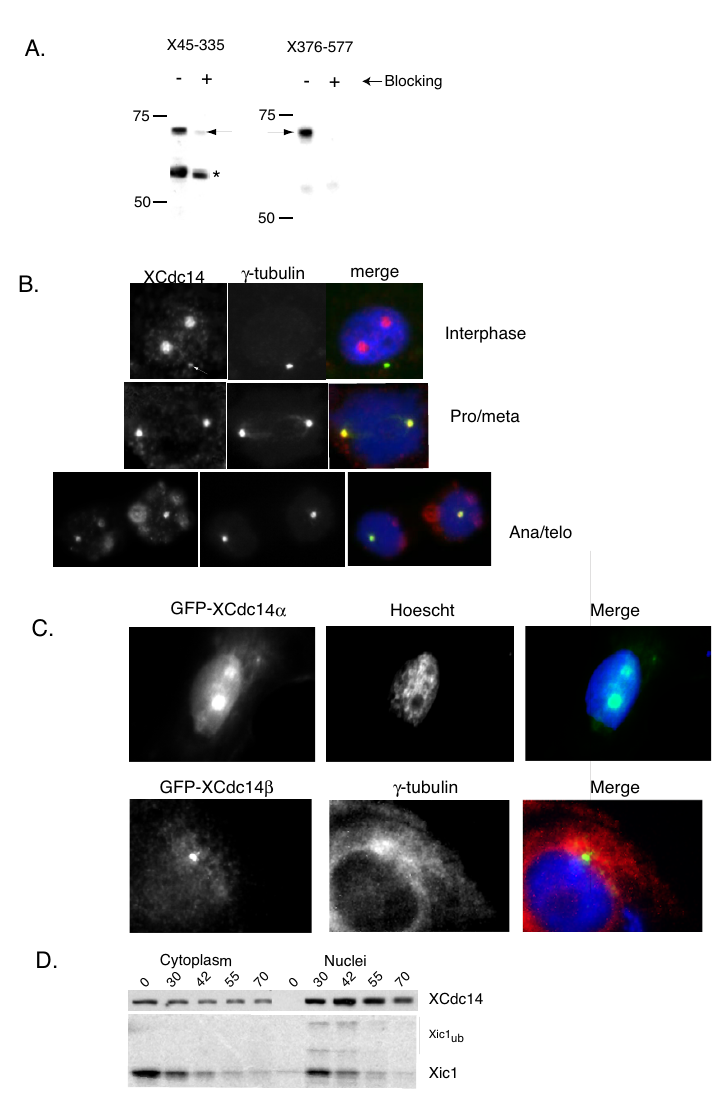
Figure 2 Xenopus Cdc14 α / β localize to the centrosome and nucleolus. A. Characterization of anti-XCdc14 antibodies. Affinity purified antibodies raised against the N- (aa 46–336) and C-termini (aa 376–577) of XCdc14 α were used to Western blot Xenopus egg lysate. Arrows indicate a protein band that cross-reacts with both antibodies and that is competed away by pre- incubation of the antibodies with the immunizing antigen. The asterisk indicates a cross-reacting protein with X46-336 antibod- ies that partially competed by preincubation. This is likely to represent XCdc14 β . B. XCdc14 α / β localizes to the centrosome and nucleolus. Antibodies raised against the N-terminus of XCdc14 α were used to immuno-stain Xenopus XTC cells. The cells were co-stained with the centrosomal marker γ -tubulin. The arrow in the upper left panel indicates XCdc14 α / β localization to the centrosome in an interphase cell. XCdc14 α / β localization to interphase nucleoli is also very prominent. C. XCdc14 α is imported into nuclei formed in Xenopus embryonic extracts. Interphase Xenopus extracts were incubated with demembranated sperm (1000 sperm/ µ l) in order to induce nuclear formation. The time course was started by moving the reaction tubes to 23°C, and at the indicated times (in minutes) samples were diluted and centrifuged through a sucrose cushion to separate cytosolic and nuclear fractions. A sample from the top of the cushion was taken for immunoblot analysis ("cytoplasm"). The cushion was aspirated, the pellet was washed and centrifuged, and the entire pellet ("nuclei") was loaded on SDS PAGE for sub- sequent immunoblotting with anti-XCdc14 α antibodies. In vitro translated and 35 S-labeled Xic1 was used as a positive control for nuclear formation and import (bottom panels). Xic1 was imported into the nucleus and destroyed by 55 minutes. Ubiquiti- nated forms of Xic1 can be seen in the nuclear